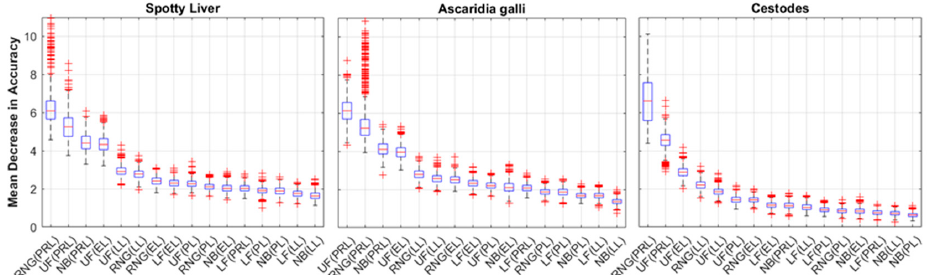
Figure 6. Feature importance measured through the mean decrease in accuracy for the three responses with the highest AUC values—( left ) Spotty Liver Disease, ( middle ) Ascaridia galli , and ( right ) Cestode infections. The responses have been classified according to the location of the hen on either the range (RNG), upper feeder (UF), lower feeder (LF), or nest box (NB) during pre-lay (PRL), peak lay (PL), late lay (LL), or end of lay (EL).